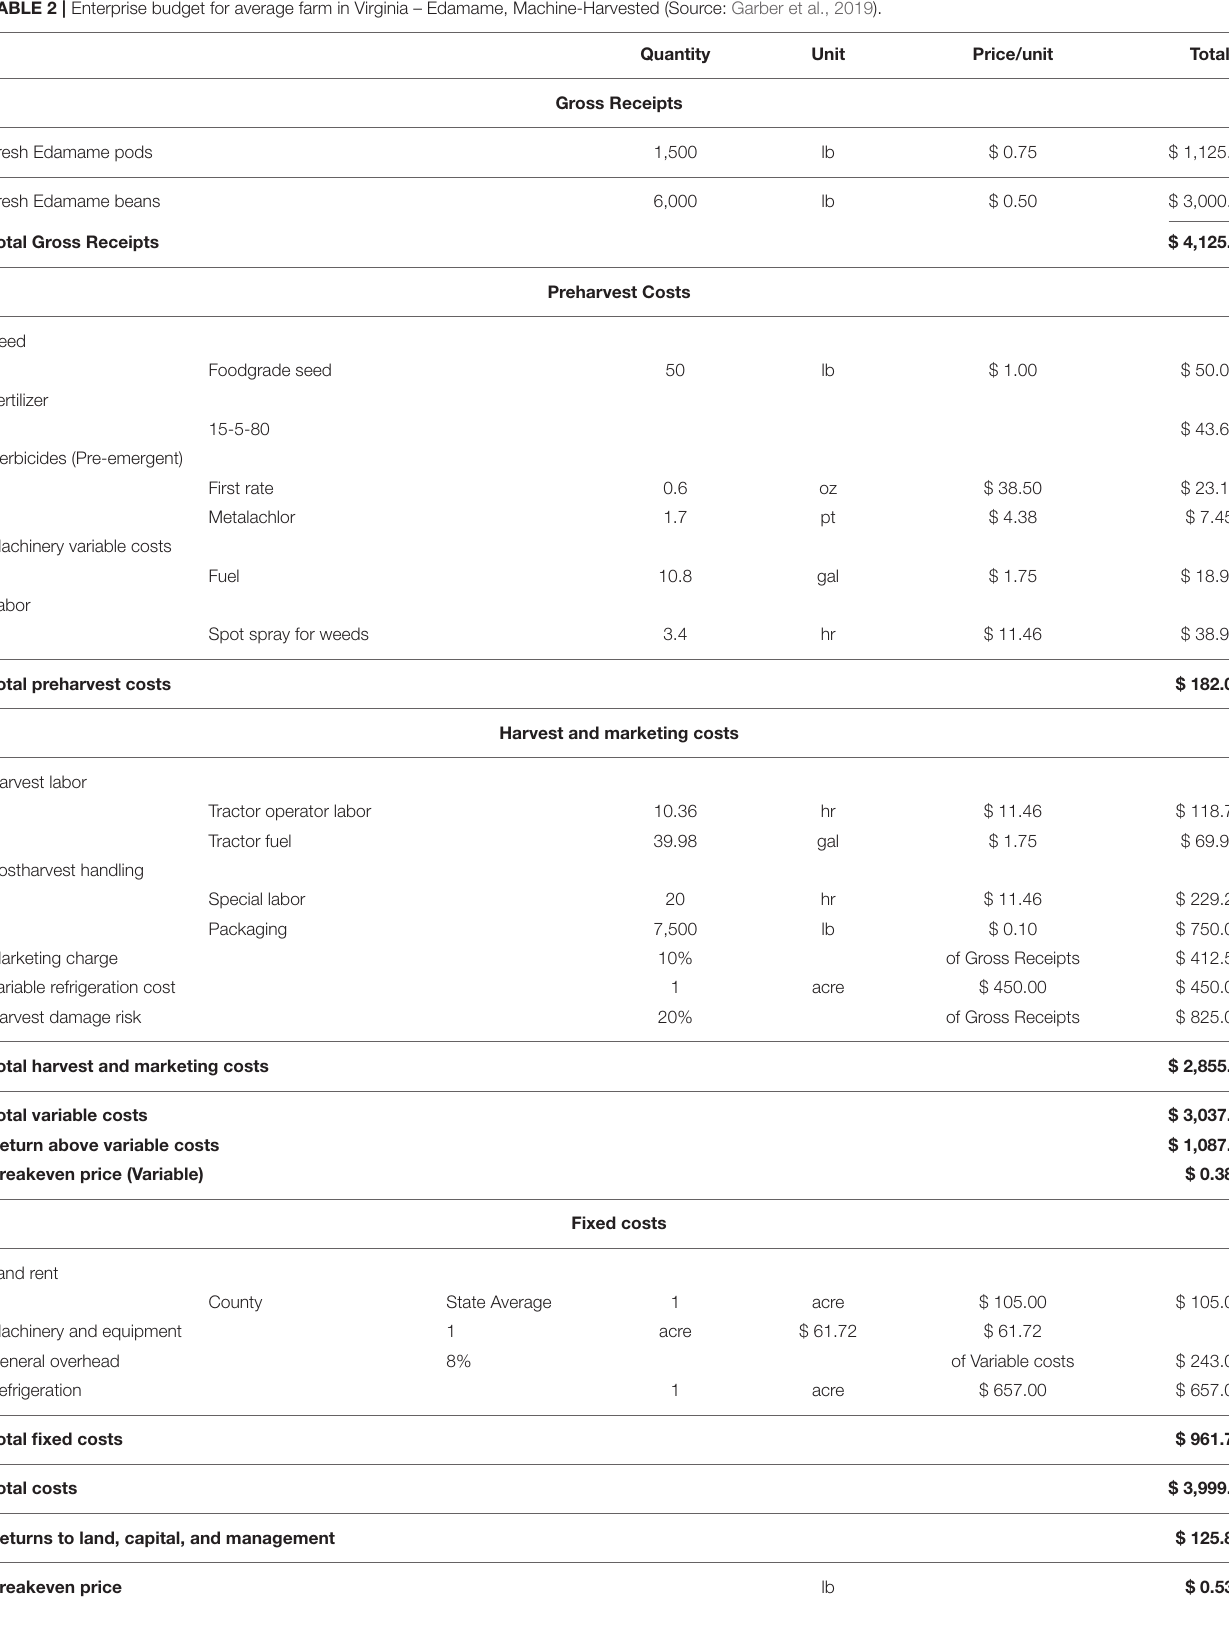
TABLE 2 | Enterprise budget for average farm in Virginia – Edamame, Machine-Harvested (Source: Garber et al., 2019). Fresh Edamame